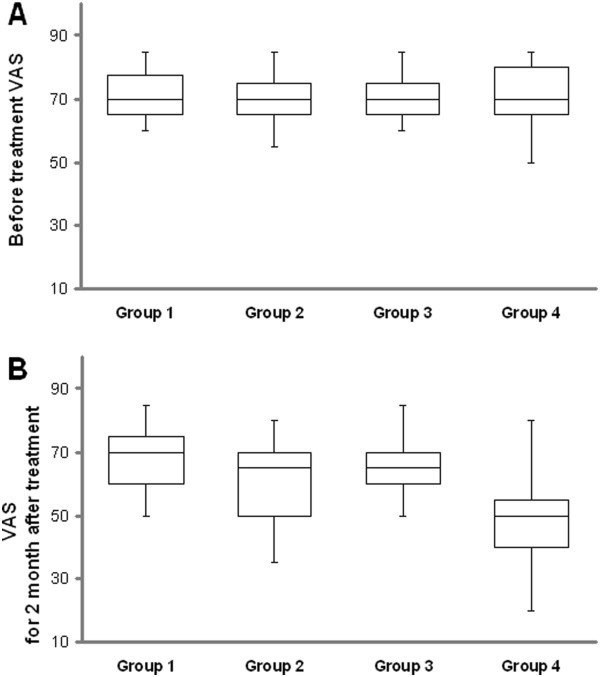
An illustration of all groups, the distribution of values for visual analogue scale (VAS): (A) before treatment and (B) 2 months after treatment.